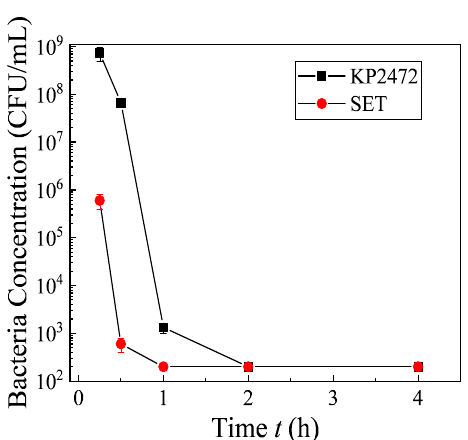
Figure 8. Antimicrobial tests of a mixture of the control Fe 2 O 3 and Cu 2 O NPs against KP2472 and SET in a dark environment. The results represent 3 independent growth experiments and are expressed as mean and standard deviation of CFU/mL.